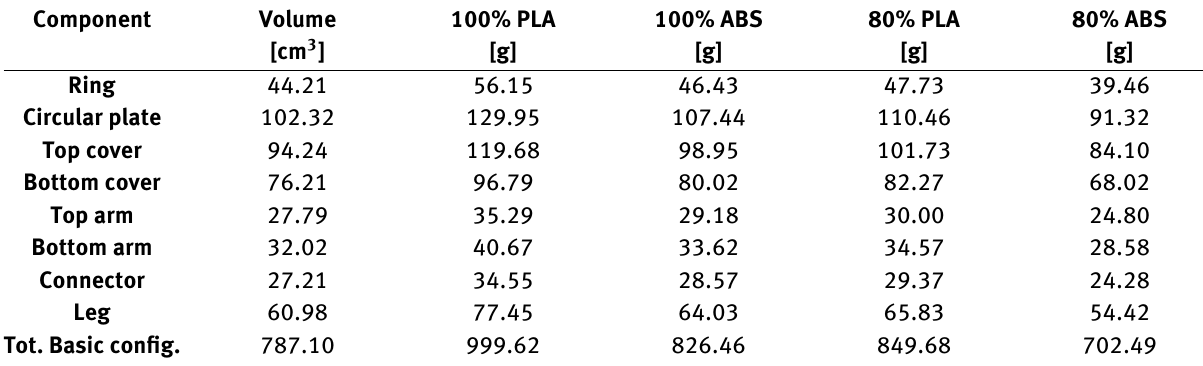
Table 3: Partial and total weights for the basic configuration of the drone with four arms and four rotors. Component